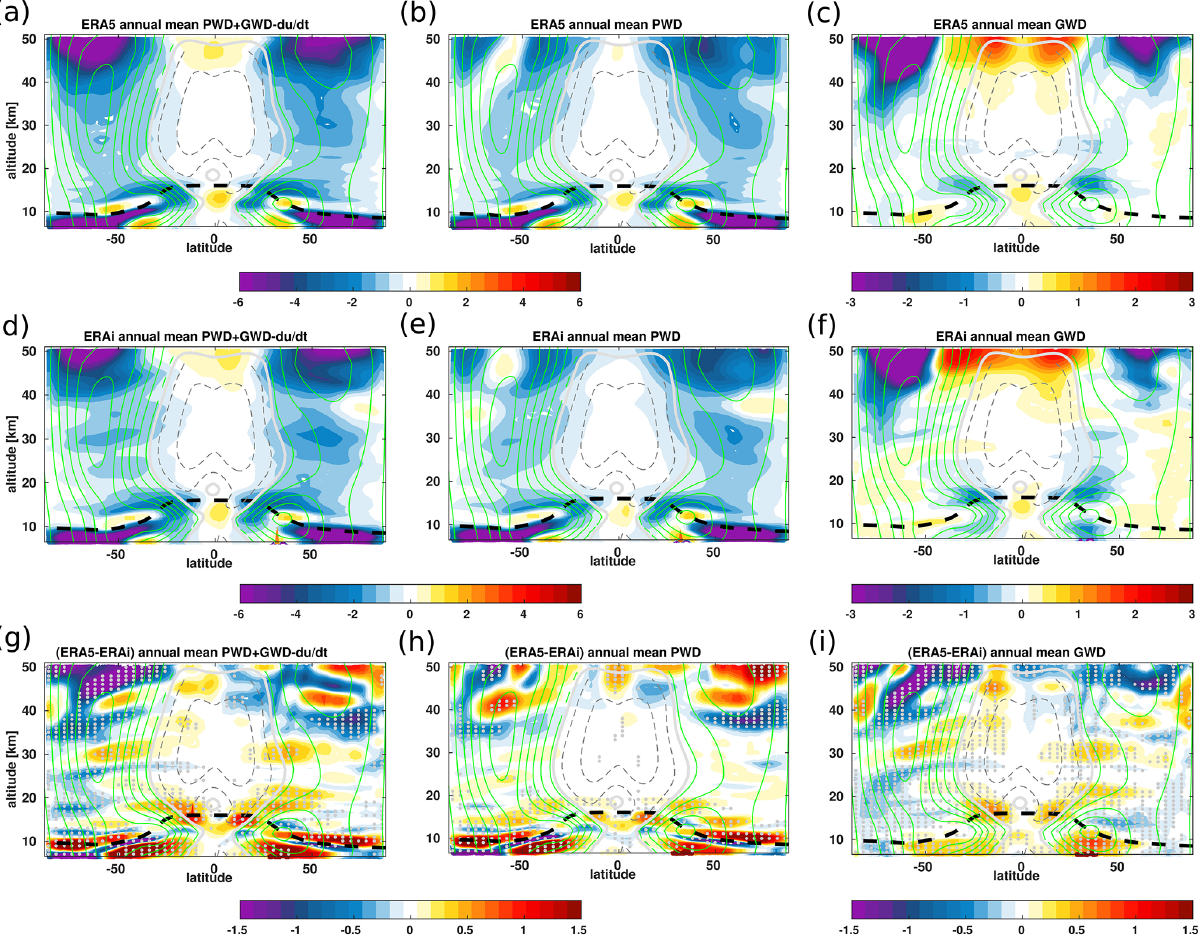
Figure 10. Zonal mean distribution of the annual mean net wave forcing (planetary wave drag + gravity wave drag − d u/ d t ) (a, d) , planetary wave drag (b, e) , and gravity wave drag (c, f) together with the associated differences (g–i) between the ERA5 (a–c) and ERA-Interim reanalyses (d–f) for the 1979–2018 time period. The unit of the wave drag is in ms − 1 d − 1 . The climatological tropopause from the ERA- Interim is indicated as the dashed black horizontal line. The thick white line indicates the zero-line zonal mean wind. The thin green and grey lines indicate the climatological zonal mean wind. Grey dots in panels (g–i) indicate regions where the differences between the ERA5 and ERA-Interim reanalyses are statistically significant at 95% estimated using Student’s t